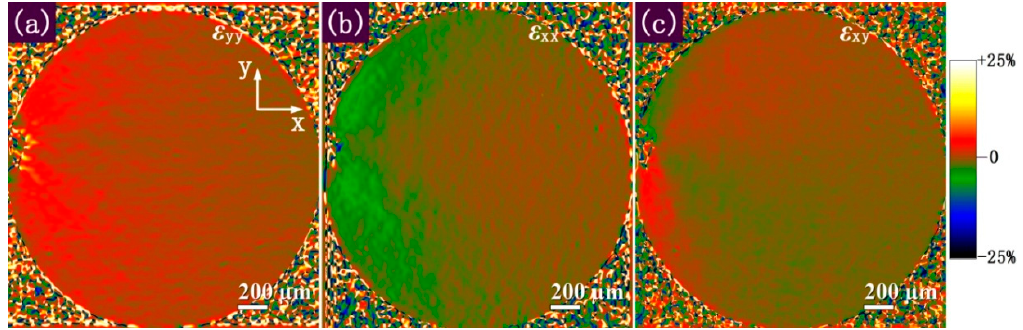
Figure 6. Strain fields at the stage of crack initiation corresponding to Figure 3d measured by using the GPA method: ( a ) ε yy strain field; ( b ) ε xx strain field; ( c ) ε xy strain field.